Question: Sum up the contents of this chart in one sentence.
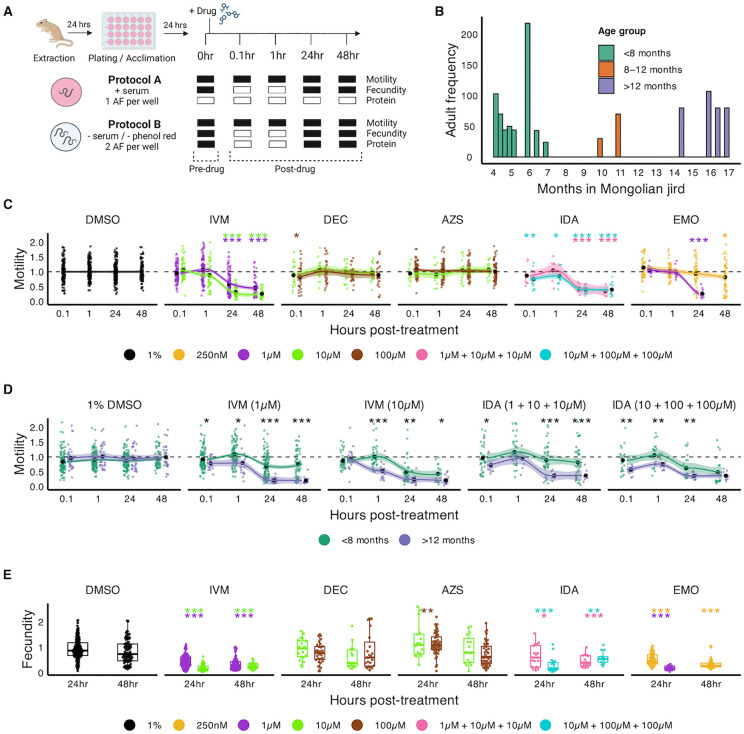
Answer: Antifilarial effects on Brugia adult motility and fecundity. (A) Schematic depicting protocols used to collect motility, fecundity, and protein samples at specific time points for adult female B. pahangi . Protocol B was optimized for the collection of excretory-secretory proteins. For all fecundity measurements, media was collected and replaced at 0, 24, and 48 hours. Created in BioRender. Zamanian, M. (2026) https://BioRender.com/q11kwnp . (B) Age distribution of adult female worms used in phenotypic assays. (C) Motility responses to IVM, DEC, AZS, IDA, and EMO treatments colored by concentration. Motility values were normalized to baseline motility (time = 0) for each individual parasite represented by the black dashed line. Statistical differences are shown for post-treatment time points compared to 1% DMSO controls at the matched time point via t-test to evaluate decreases in motility. (D) Motility responses to IVM treatments stratified and colored by the age group adult females occupied. For each drug condition and time point, statistical differences between age groups were calculated via t-test. (E) Fecundity responses to drugs as measured by the progeny released (segmented microfilariae pixel area) in the presence of drugs after 24 hours and 48 hours, colored by concentration and normalized to 24 hour 1% DMSO controls. Statistical significance was calculated via t-test comparing DMSO and drug treated groups at matched time points. P-values throughout figure are reported as follows, *: p < 0.05, **: p < 0.01, ***: p < 0.001, ****: p < 0.0001. 48 hour motility and fecundity data were not collected for 1 μM EMO. Plot points in C-E represent wells of 1-2 adult parasites; each condition was performed for at least 4 technical replicates (wells) per experiment and each experiment was repeated across at least three biological replicates (parasite cohorts).